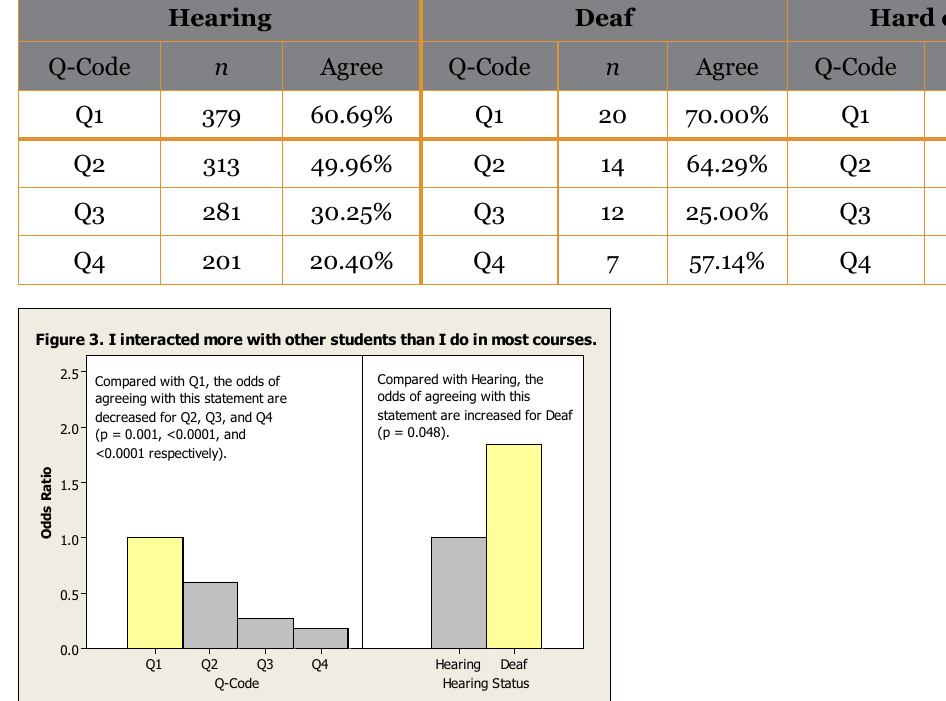
Figure 3 . Odds-Ratios for “I interacted more with other students than I do in most courses.”